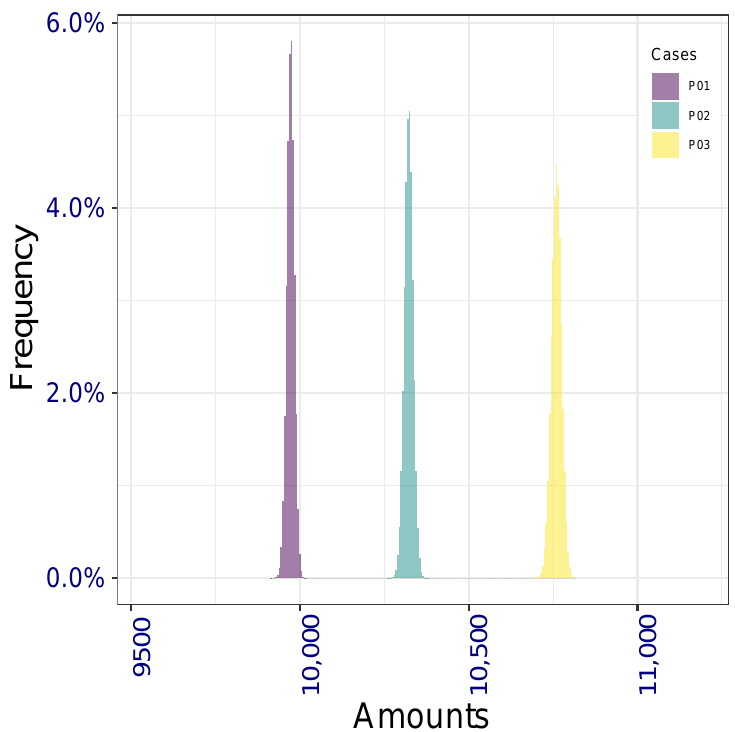
Figure 3. Impact of the number of enhanced annuities: empirical distributions of the annual benefit payout at time t = 5.